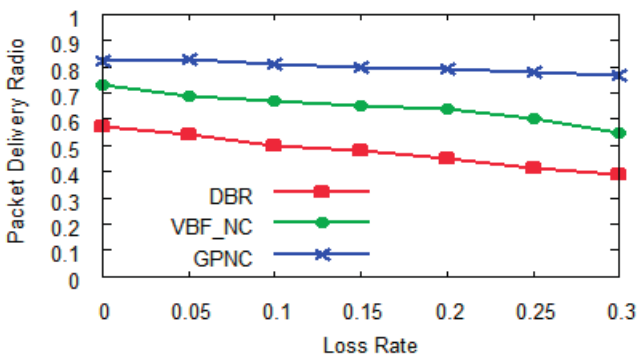
Figure 12. Packet delivery ratio with the increase of loss rate when N =